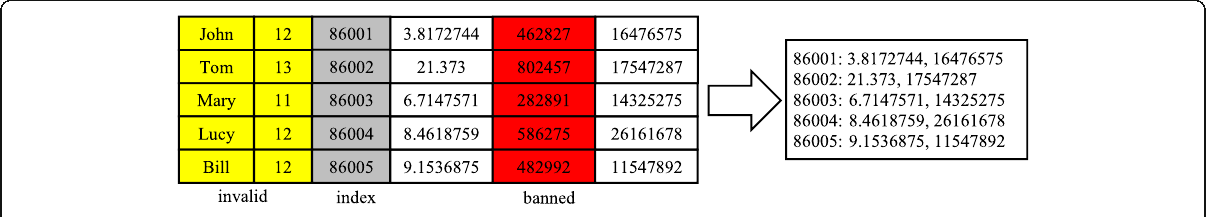
Fig. 6 Sketch of preprocessing of a cover CSV